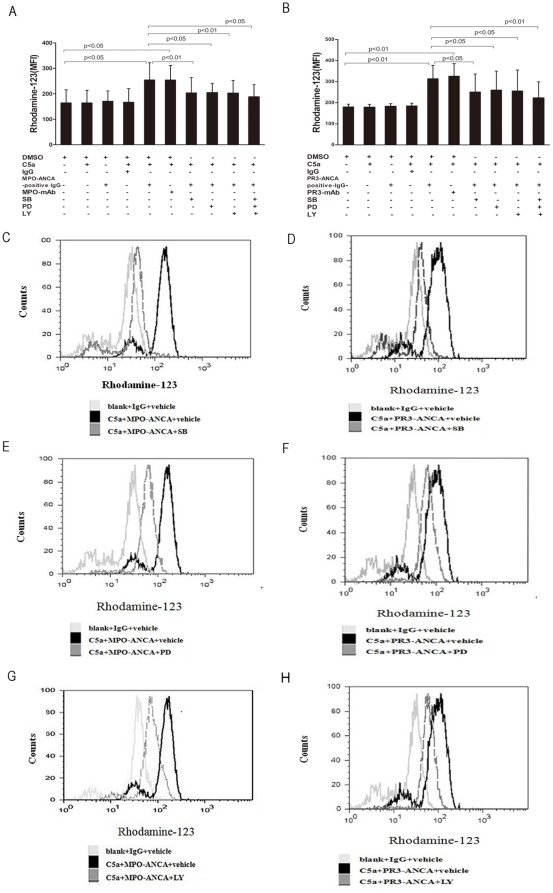
Neutrophil respiratory burst induced by patient-derived MPO-ANCA-positive IgG or PR3-ANCA-positive IgG in C5a-primed cells.Neutrophil respiratory burst induced by patient-derived MPO-ANCA-positive IgG (A) or PR3-ANCA-positive IgG (B) was measured by conversion of dihydrorhodamine-123 (DHR-123) to rhodamine-123 in C5a-primed cells in the presence and absence of SB202190, PD98059, LY294002 or the mixture of above-mentioned three inhibitors, respectively. Differences of MFI between groups were assessed using the paired t test. C–H were representative histograms showing that MPO-ANCA-positive IgG and PR3-ANCA-positive IgG induced respiratory burst in C5a-primed neutrophils and that inhibition of p38MAPK, ERK and PI3K reduced the ANCA-induced respiratory burst. Bars represent mean±SD of 5 MPO-ANCA-positive IgG and 3 PR3-ANCA-positive IgG preparations, each measured on neutrophils of 10 independent experiments and donors.